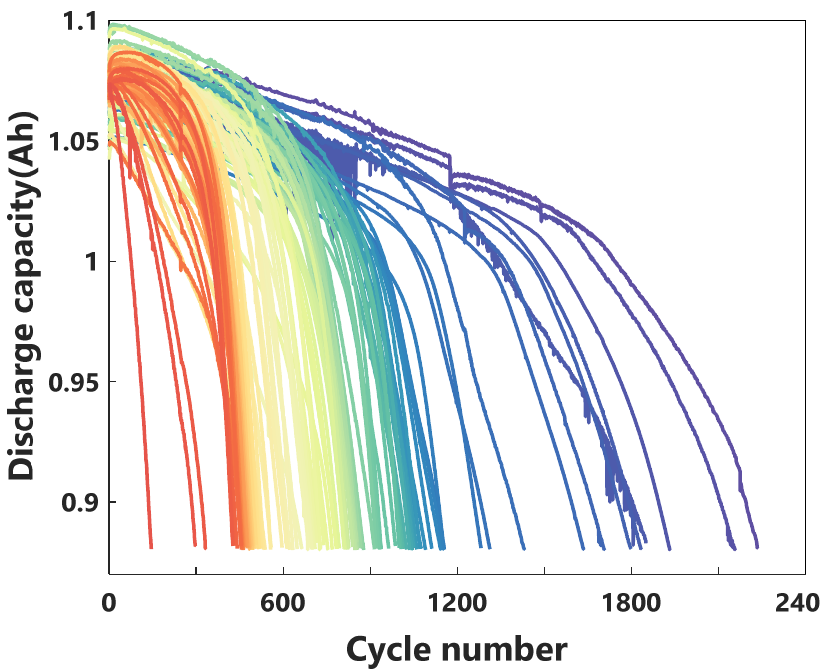
Figure 1. The observed discharge capacity curves; the color of the curves changes along the spectrum according to the cycle life.